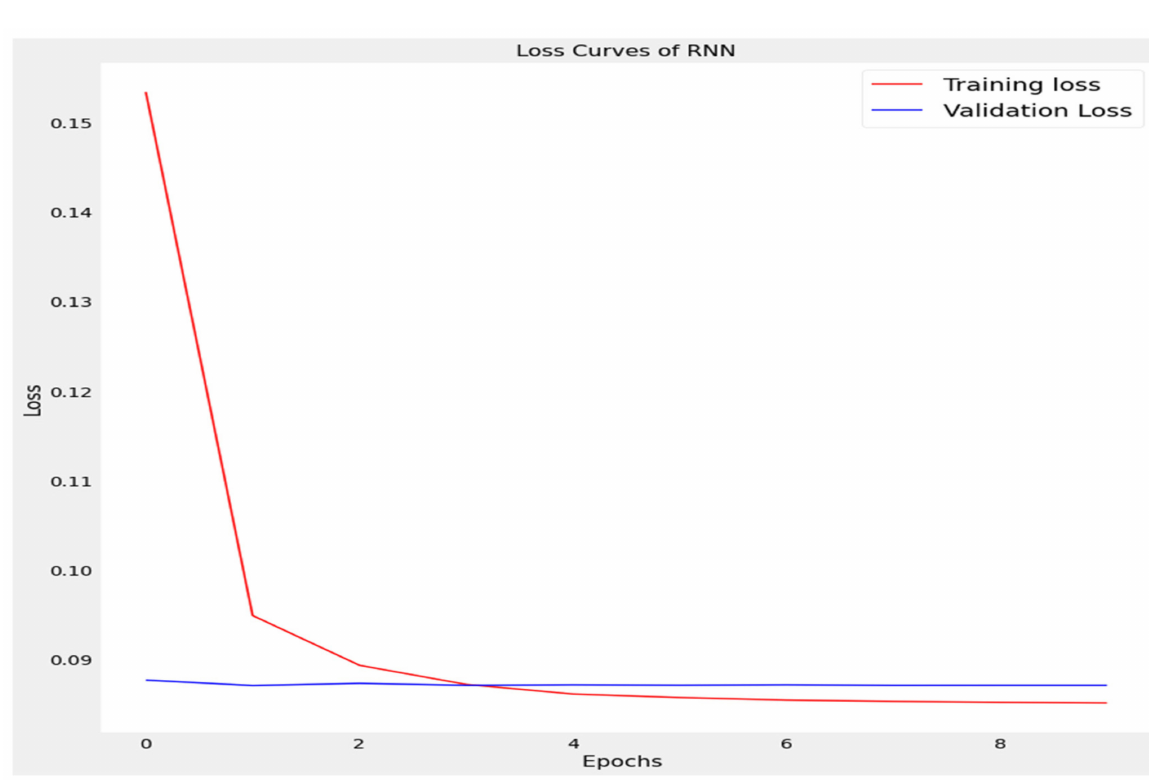
Figure 6. Loss curve of long short term memory (LSTM).